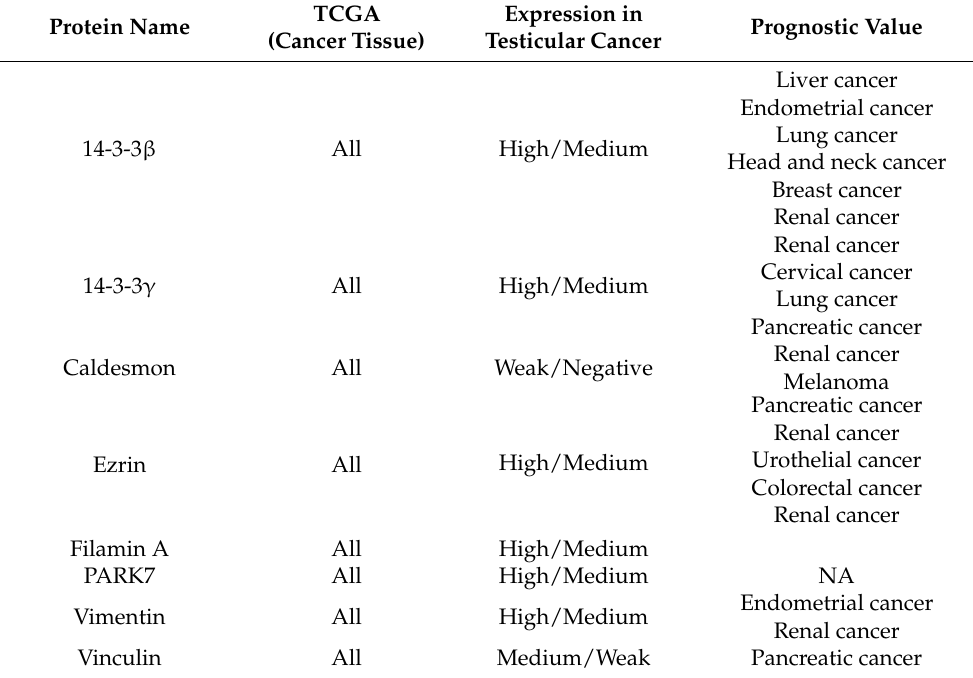
Table 1. Prognostic value of selected proteins (human protein database).